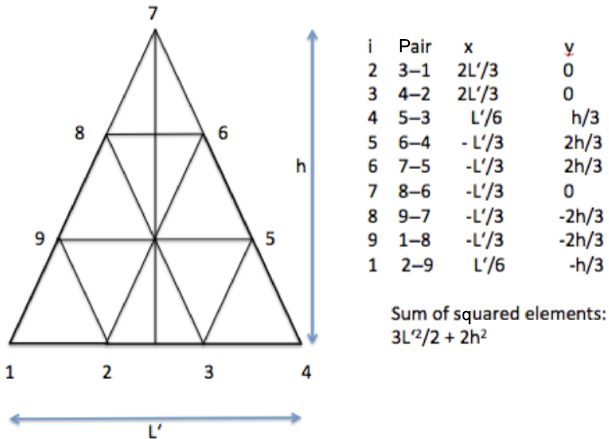
Figure 6. Application of Eq. (12) on a triangle with two equal sides for N =